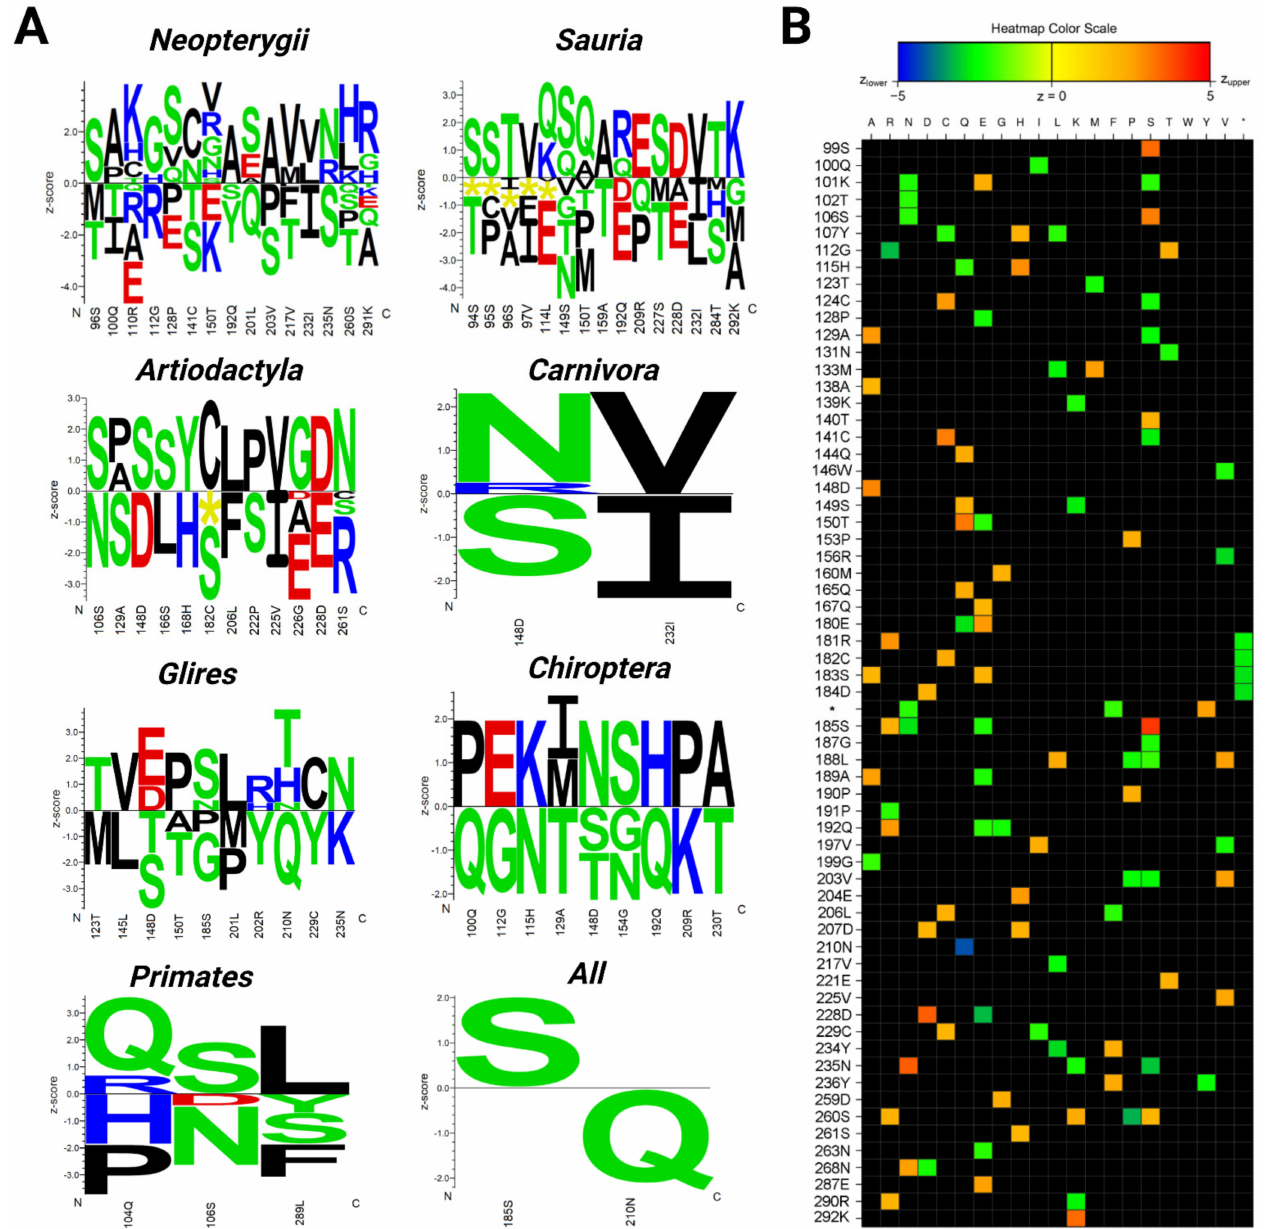
Figure 7. Correlation of the most commonly altered p53 amino acid residues with the maximal lifespans of the analyzed species. ( A ) Logos quantifying the strength of the p53 core domain residue association (related to the human aa 94–293 according to the p53 canonical sequence) with the maximal lifespan in years in the analyzed subgroups of animals. Amino acid residues on the positive y-axis were significantly associated with the prolonged lifespan phenotype and residues on the negative y-axis were significantly associated with the shorter lifespan phenotype (significance threshold p -value ≤ 0.05). The height of each letter representing the strength of the statistical association between the residue and the data set phenotype. The amino acids are colored according to their chemical properties as follows: acidic (DE): red, basic (HKR): blue, hydrophobic (ACFILMPVW): black, and neutral (GNQSTY): green. ( B ) Heatmap visualization of the strength of the residue association (without a Bonferroni correction). The color scale ranges from blue (z < − 5) to red (z > 5). Each column corresponds to one of the 20 proteinogenic amino acids and each row to a position in the submitted multiple sequence alignment (Supplementary Materials File S4). * Indicates site of the amino acid